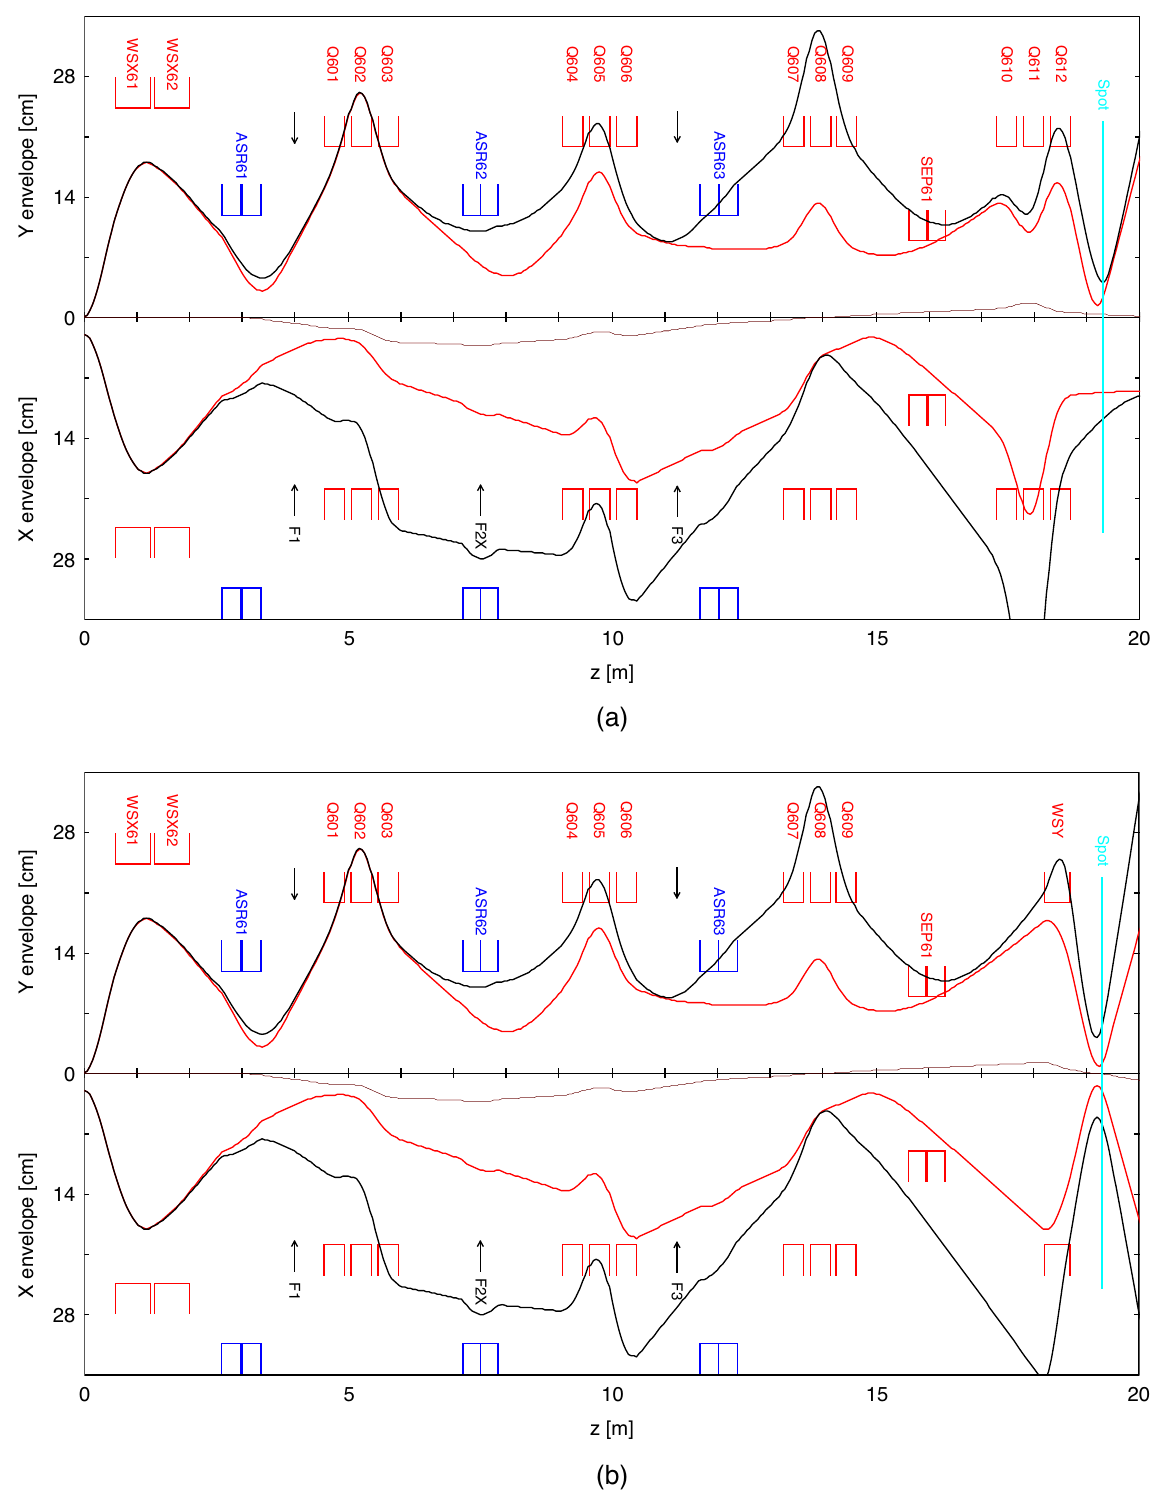
FIG. 5. Beam envelopes calculations of the μ E 4 beamline using TRANSPORT : (a) Current μ E 4 beamline; (b) upgraded μ E 4 beamline with a solenoid replacing the last quadrupole triplet. Initial parameters used in TRANSPORT are (half-width) x ¼ 20 mm, x 0 ¼ 200 mrad, y ¼ 2 . 5 mm, y 0 ¼ 200 mrad, dp=p ¼ 0 (red lines) and 4.5% (black lines). The red lines indicate the first-order calculations and the black lines are the second-order calculations. The arrows represent the three slit systems with maximum jaw